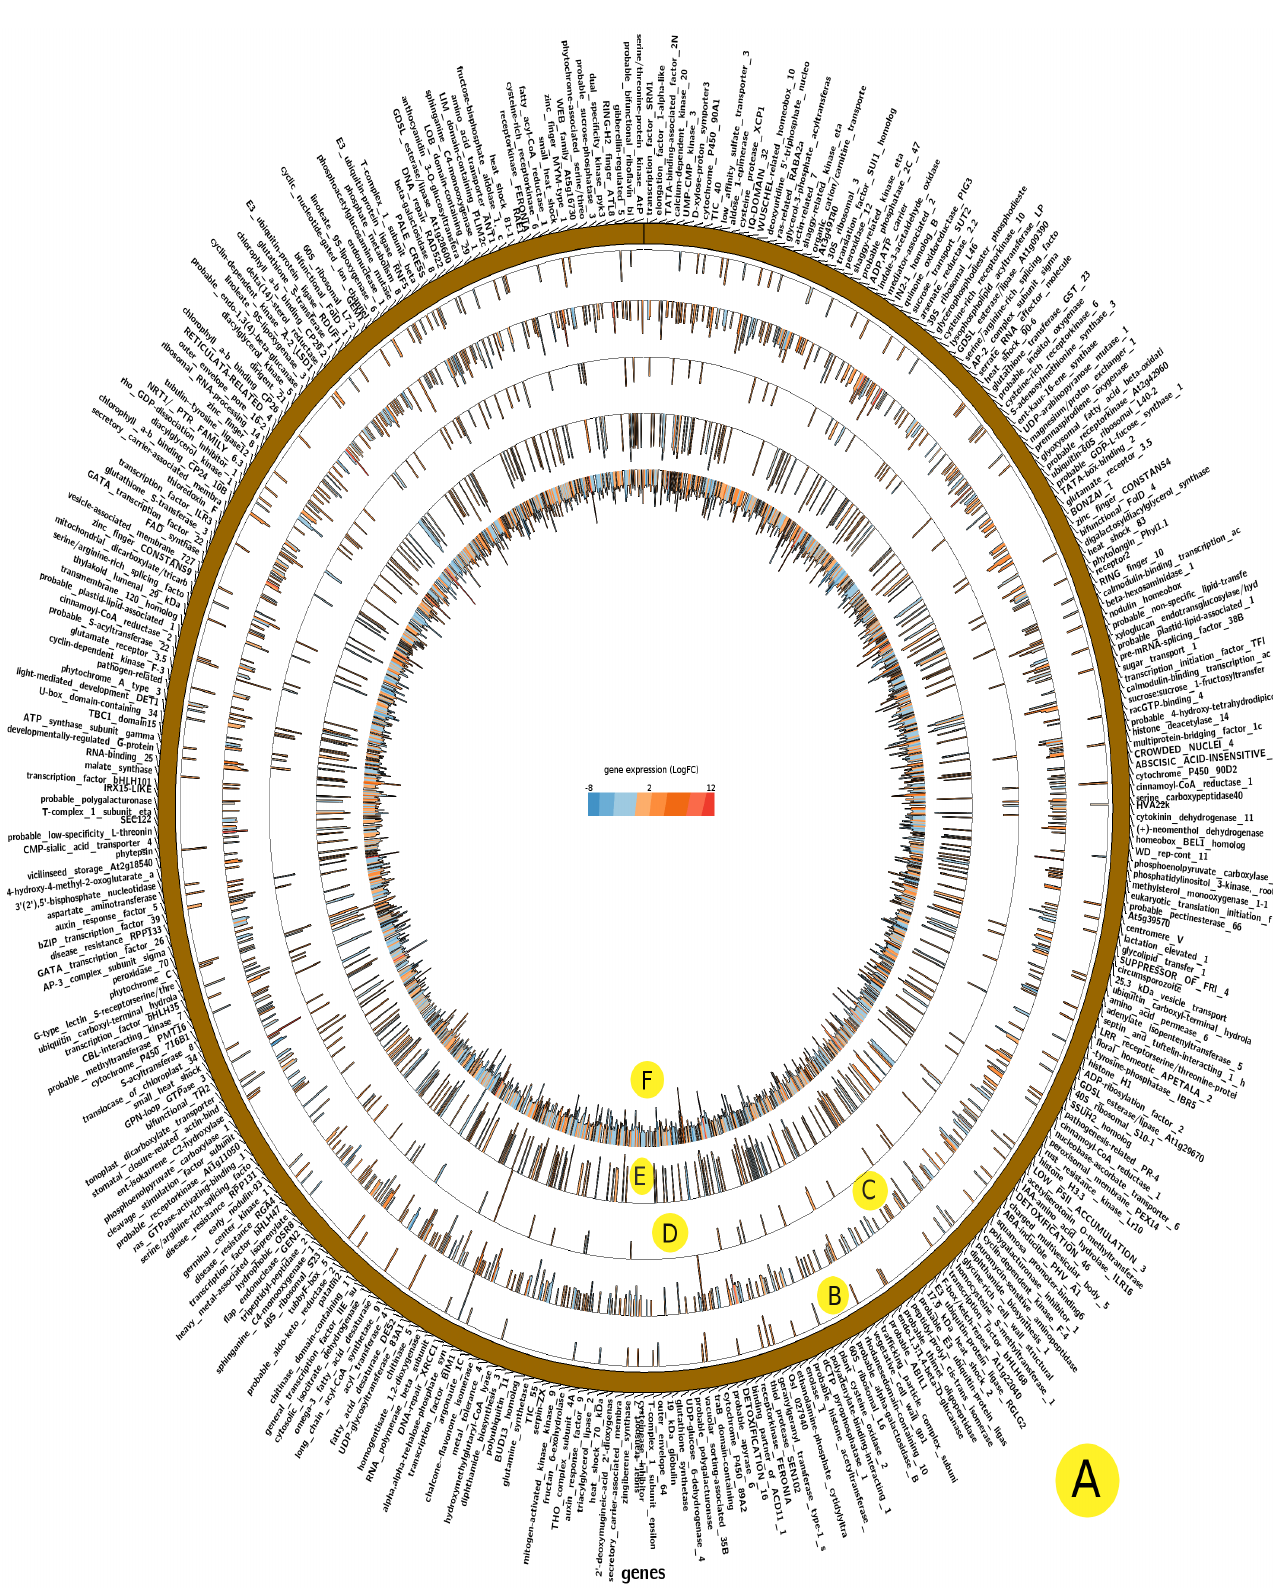
Highlights in BioScience Page 4 of